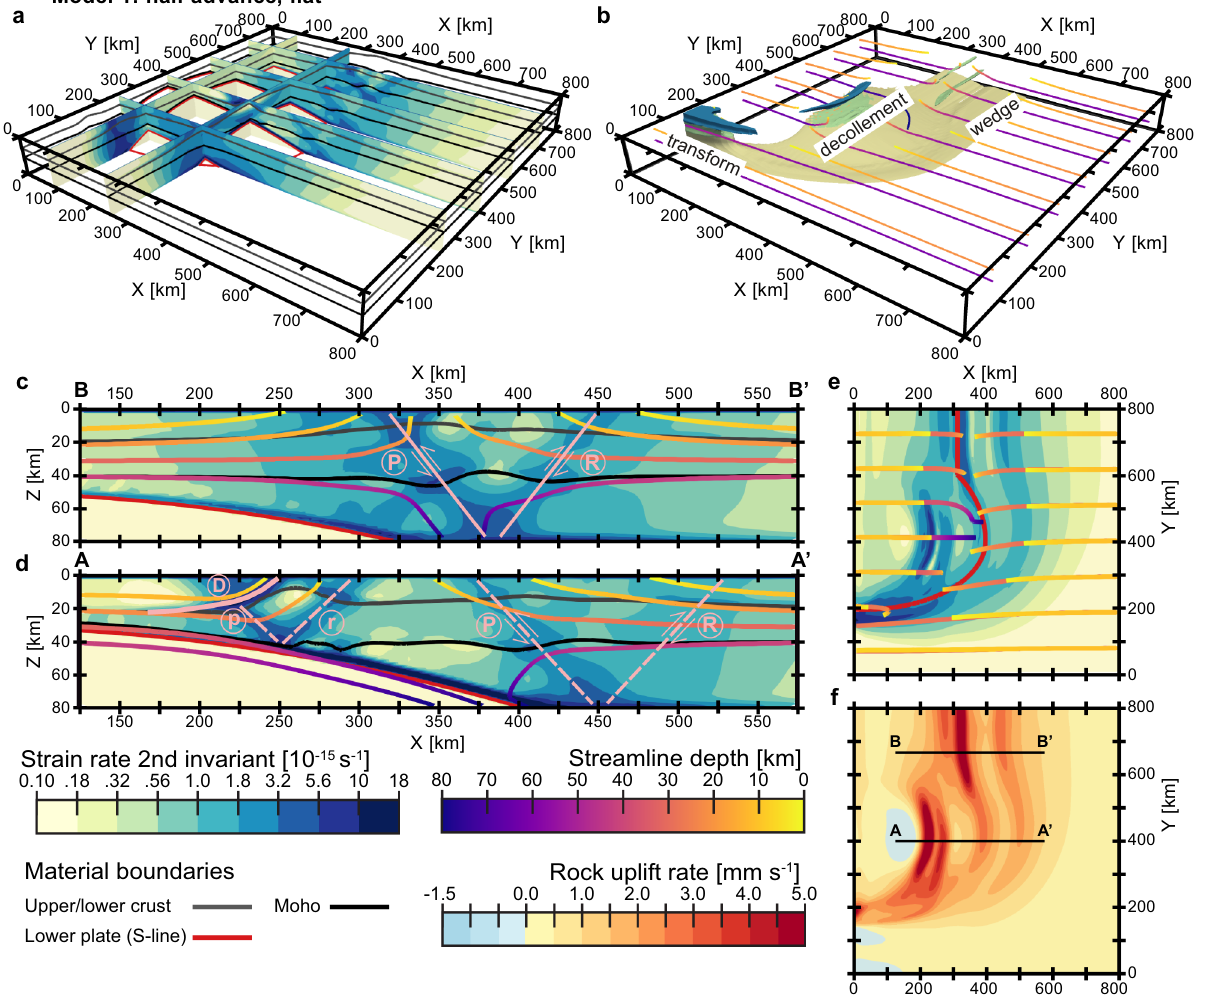
Figure 3. Overall view of model 1 (total erosion; half upper plate advance) after 6 Myr modelling time. ( a – e ) Second invariant of strain rate shown in 3D view (panels “a” and “b”), vertical cross-sections parallel to the X-axis (panels “c” and “d”), and plan view (panel “e”). ( f ) Top view of rock uplift rates at the surface. Panels “b” to “e” combine the strain rates with the motion streamlines. Panel “b” denotes the part of the model domain characterized by high strain rates (> 5·10 −15 s −1 ), with colors corresponding to material layers as in Fig. 2. In panels “c” and “d”, the pro- and retro- shear zones are marked with “P” and “R” (solid pink lines in panel “c”) and “p” and “r” (dashed pink lines in panel “d”) for structures on lithospheric and crustal scales, respectively. The shallow retro-decollement is labelled by “D” (solid pink line in panel “d”). The shadowy continuations of the lithospheric-scale (pro- and retro-) shear zones into the central part of the model are interpreted by dashed pink lines in panel “d”. The positions of the vertical cross-sections shown in panels “c” and “d” are indicated by the black lines in panel “f”. The map view in panel “e” corresponds to strain rates at 5 km depth, while the particle trajectories (streamlines) shown there originate at 10 and 30 km depth. In the vertical cross-sections, the corresponding relatively shallow motion streamlines show exhumation of upper and lower crustal material, that increases from both sides towards the model center and accelerates dramatically at the main shear zones (panels “c” and “d”). In the horizontal plane, these flow lines generally demonstrate a nearly parallel influx of material, while in the front portion of the model they pass around the indenter, deflecting slightly in the negative Y-direction (panel